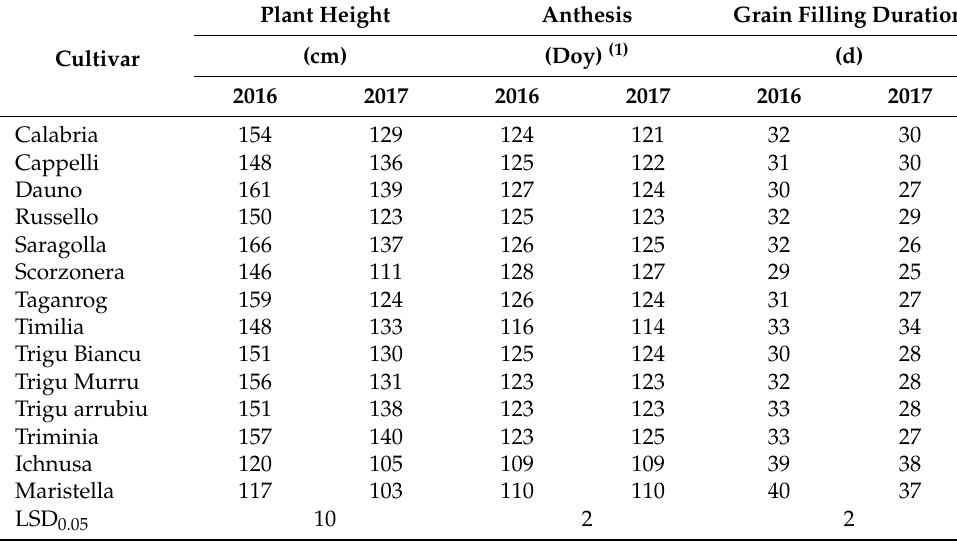
Table 3. Plant height, anthesis date and grain filling duration. Means and LSD 0.05 for the comparison of cultivar × year means at the same or different levels of